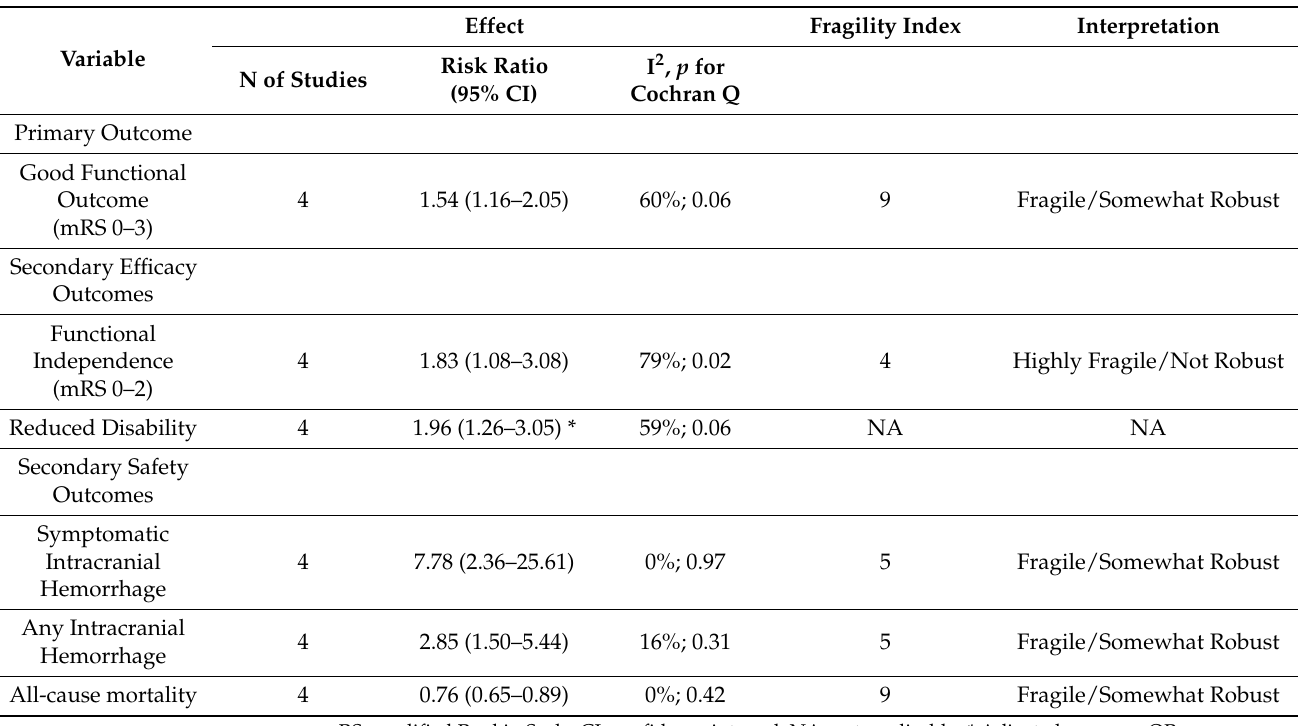
Table 2. Overview of analyses for primary and secondary